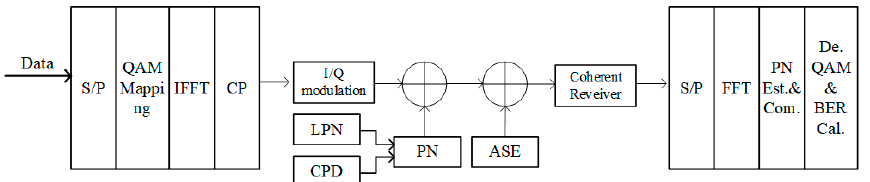
Figure 1. Block diagram based on the proposed phase noise model for a CO-OFDM SDM